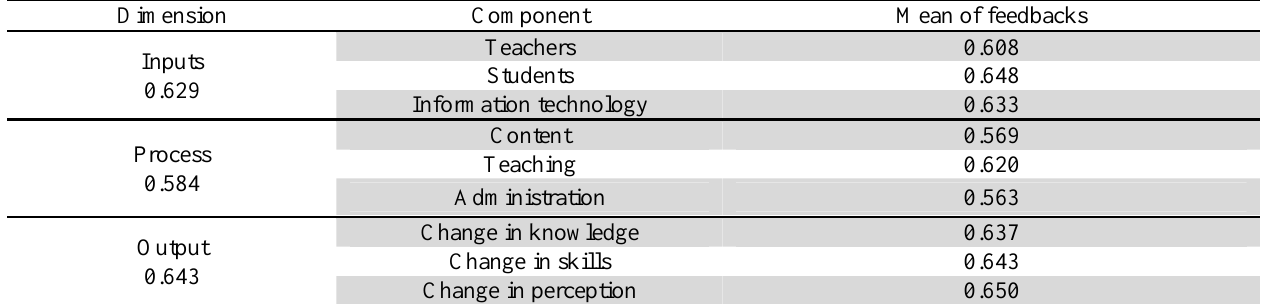
Mean of feedbacks Component